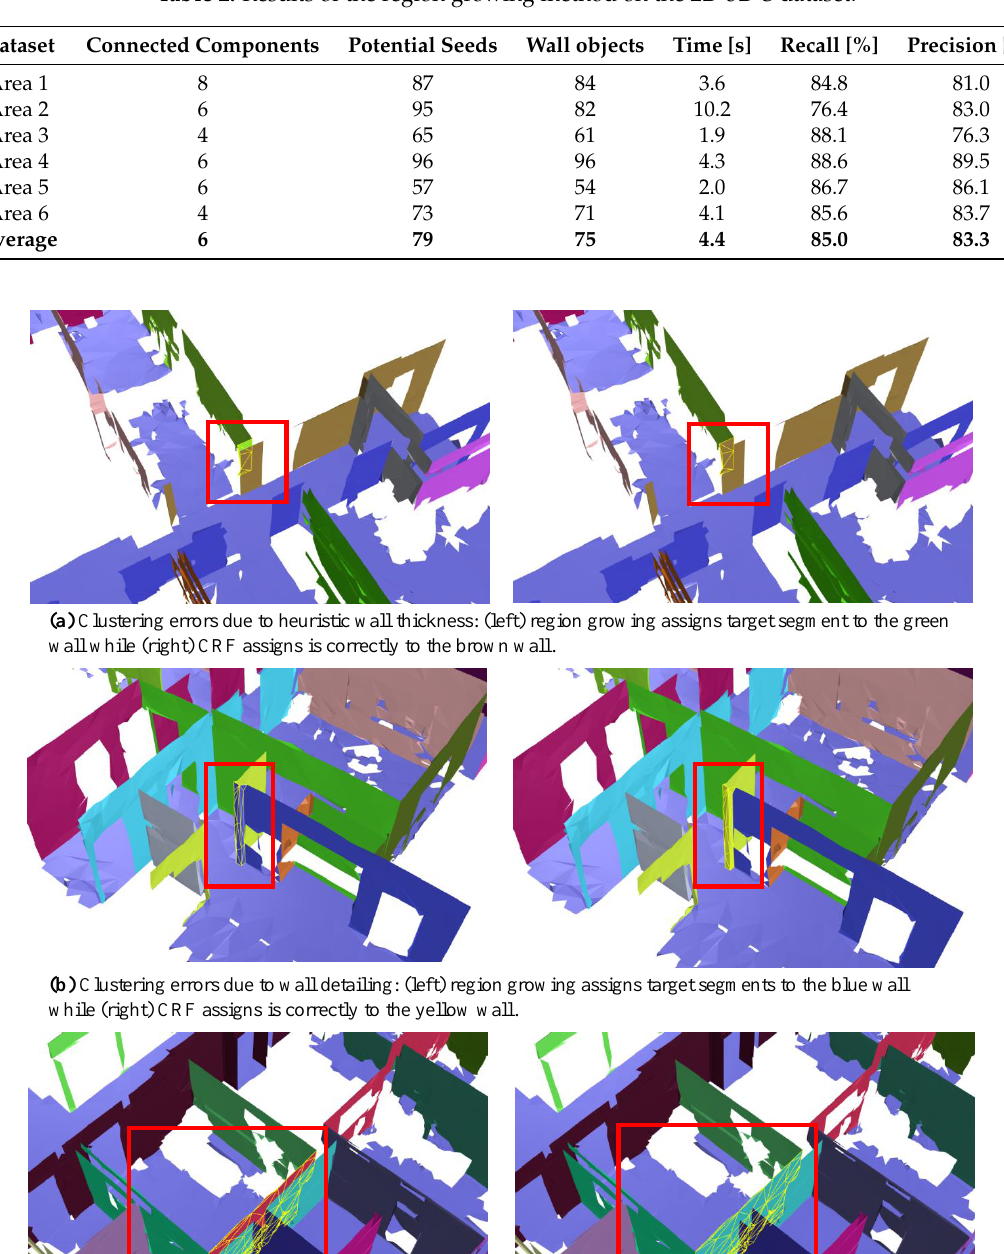
Table 2. Results of the region growing method on the 2D-3D-S dataset.